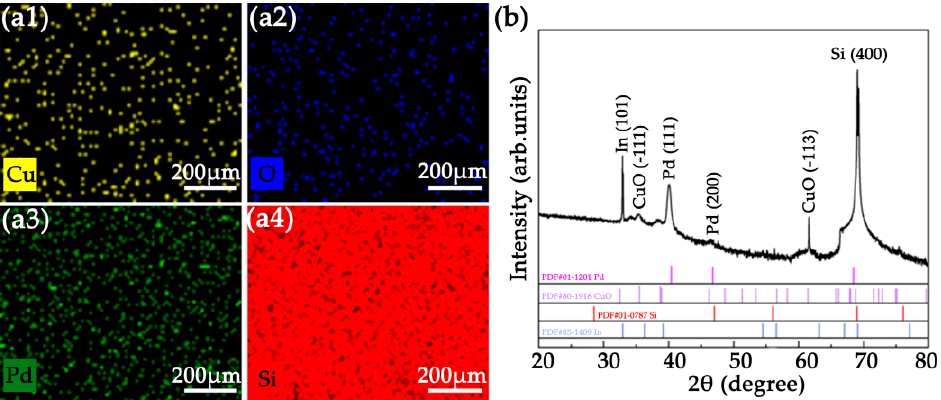
Figure 3. ( a ) EDS mapping images of the Si nanospike after coating heterostructured CuO and Pd nanofilms. (a1) Cu element, (a2) O element, (a3) Pd element, (a4) Si element; ( b ) XRD pattern of the heterostructured CuO/Pd nanofilm on Si nanospike.